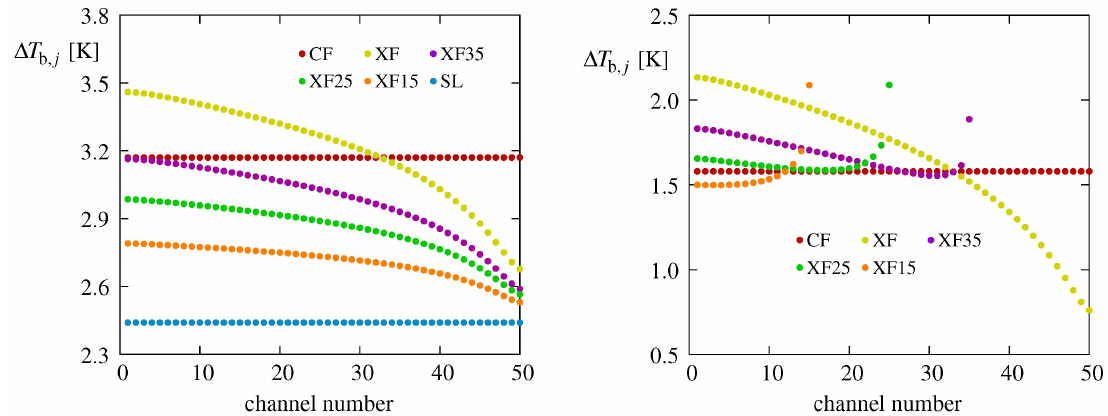
Figure 9. Microchannel outlet bulk temperatures in the bottom and top layers for ˙ V = 5.0 mL/s ( left : bottom layer; right : top layer).